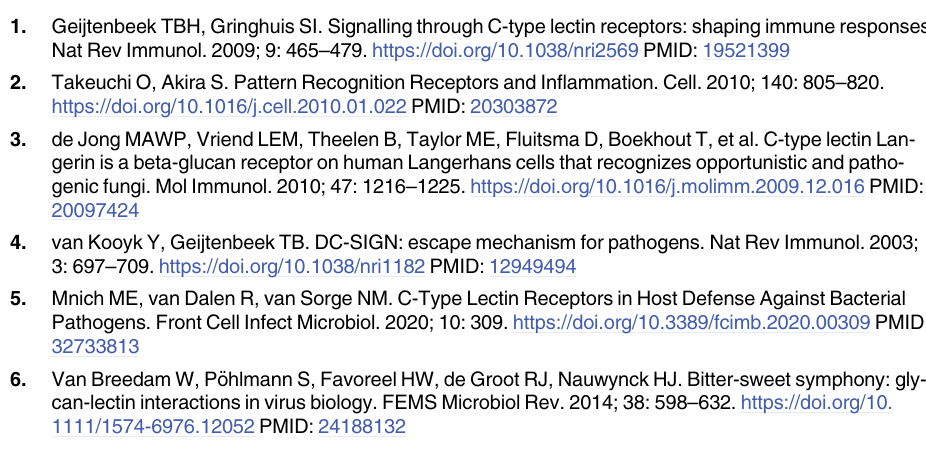
S2 Fig. Sensorgrams of DC-SIGN/S protein interaction inhibition by a range of PM26 con- centration. In panel C, peak at 68 mL correspond to DC-SIGN ECD, which is in excess, and shouldered peak from 40 to 60 mL correspond to spike protein interacting with various num- bers of DC-SIGN ECD. Fractions used for Electron Microscopy micrographs of DC-SIGN/ SARS-CoV-2 Spike protein complexes (Fig 3C) are represented by the gray square (48 to 50 mL). S3 Fig. DC-SIGN expression in MDDCs by flow cytometry analysis. The colored cell popu- lation represents MDDCs stained with antibody Anti-DC-SIGN_PE. In grey unstained MDDCs. DC-SIGN expression was analyzed by flow cytometry in a BD FACS Canto II Cell Analyzer with FlowJo V10.7.1